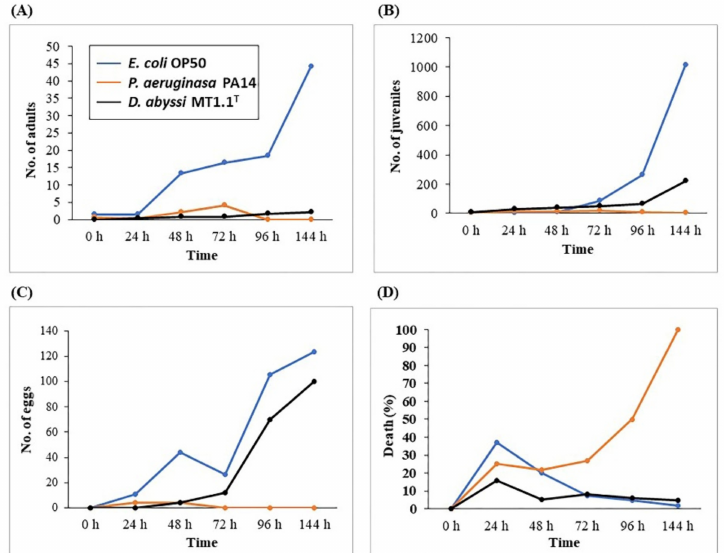
Figure 4. The pathogenicity assay of deep-sea D. abyssi MT1.1 T on the survival of C. elegans. Time course of changes in the number of ( A ) adults, ( B ) juveniles, ( C ) eggs, and ( D ) death. Data represent the mean values of three